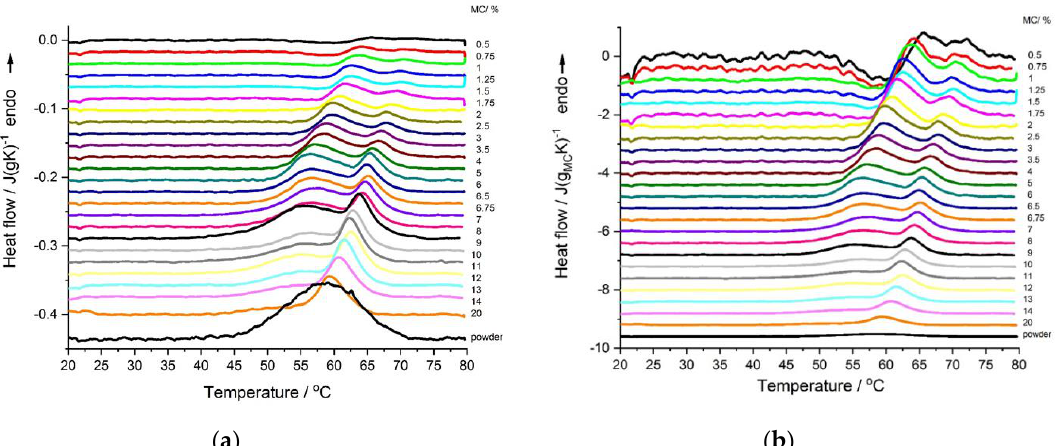
Figure 1. DSC heating scans of MC solutions with various concentrations (indicated) — ( a ) heat flow normalized to the sample weight, and ( b ) heat flow normalized to the methylcellulose (MC) weight. Curves subtracted using polynomial. For comparison, the curves are shifted in y-axis.